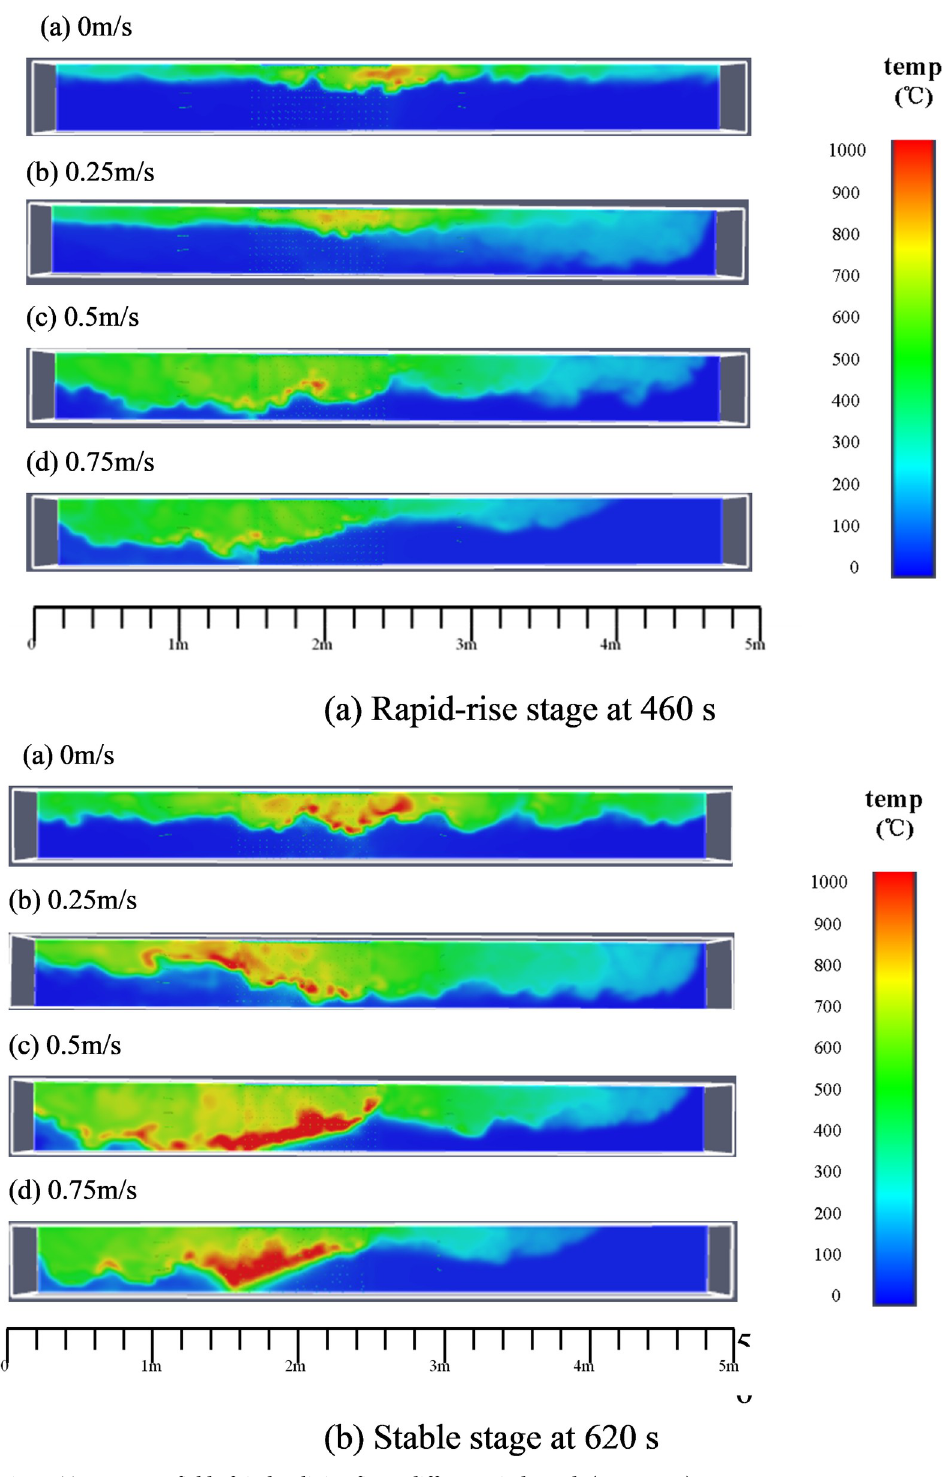
Fig 13. Temperature field of timber-lining fire at different wind speeds (Y = 0.48 m).